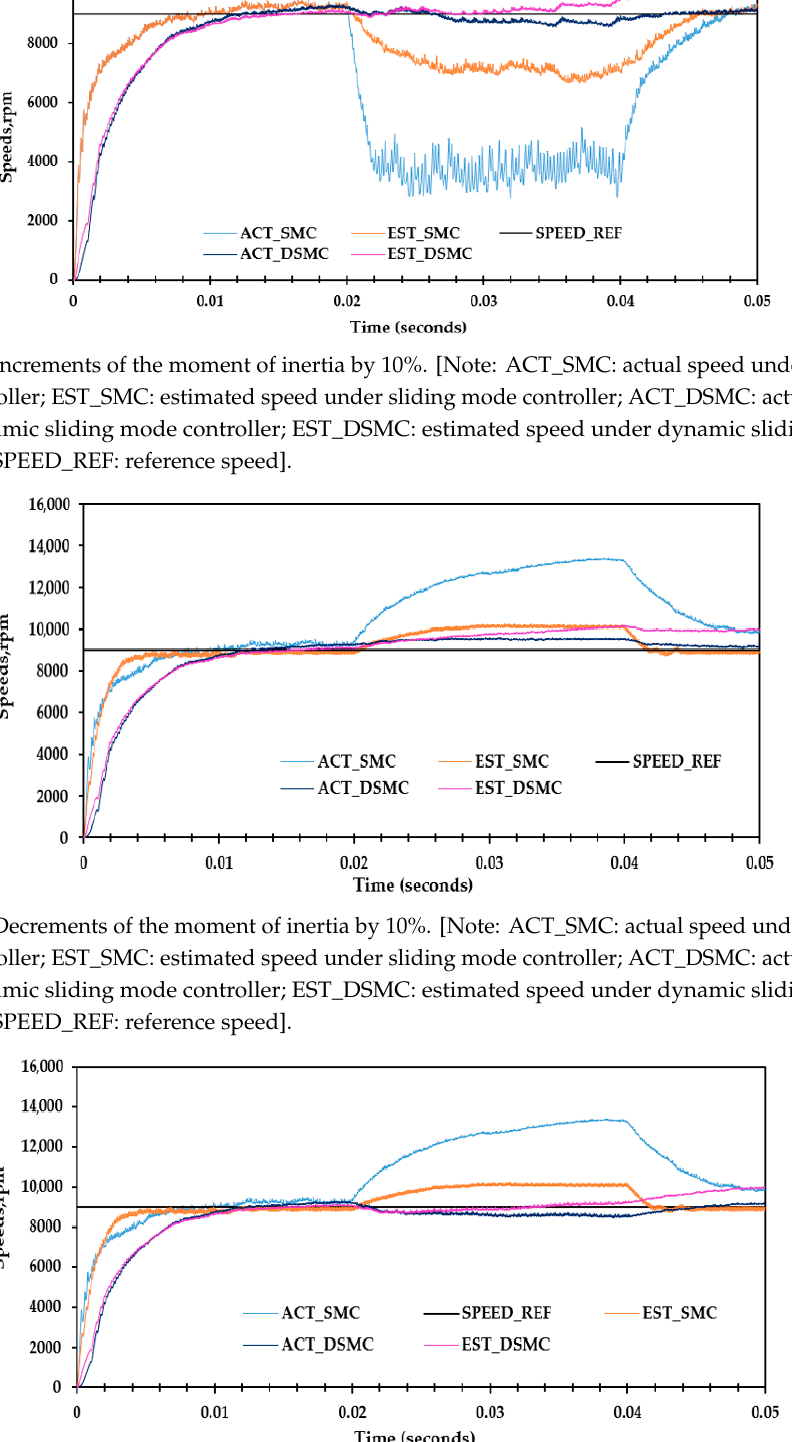
Figure 28. Changes in the switching angle to 11 degrees. [Note: ACT_SMC: actual speed under sliding mode controller; EST_SMC: estimated speed under sliding mode controller; ACT_DSMC: actual speed under dynamic sliding mode controller; EST_DSMC: estimated speed under dynamic sliding mode controller; SPEED_REF: reference speed]